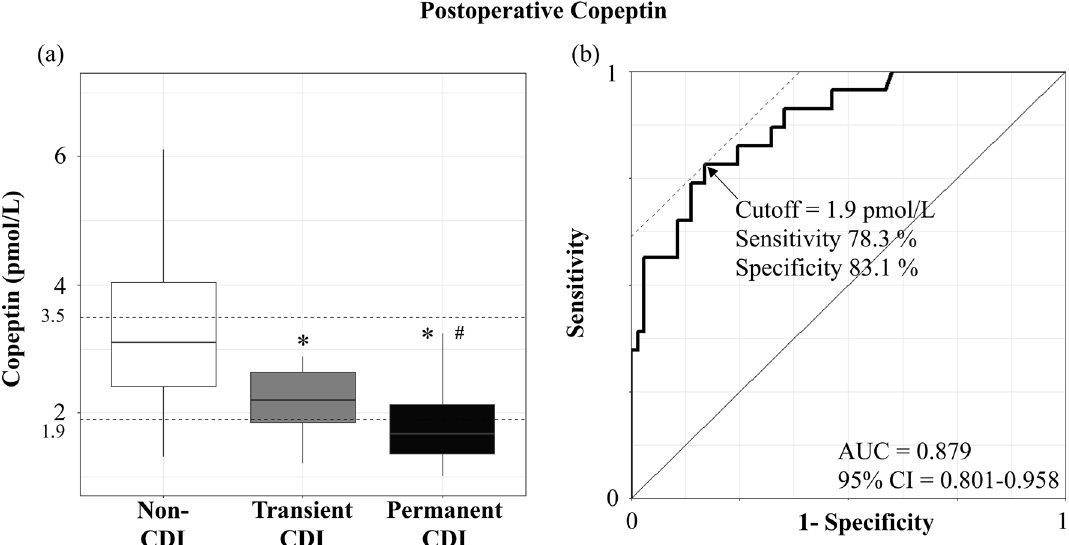
Figure 2. ( a ) Comparison of postoperative copeptin levels according to the presence of central diabetes insipidus at postoperative 3 months visit and ( b ) receiver operating characteristic curve analysis for diagnosing permanent central diabetes insipidus. ( a ) P -values versus non-CDI calculated using the Kruskal–Wallis with Dunn’s post-hoc analysis were 0.130, 0.002, and < 0.001, respectively. The dashed lines indicate the important cutoff values of 3.5 pmol/L and 1.9 pmol/L from the top to the bottom. Outlier values have been removed. *, P < 0.05, versus Non-CDI. #, P < 0.05 compared with Transient CDI. ( b ) Area under the curve (AUC)